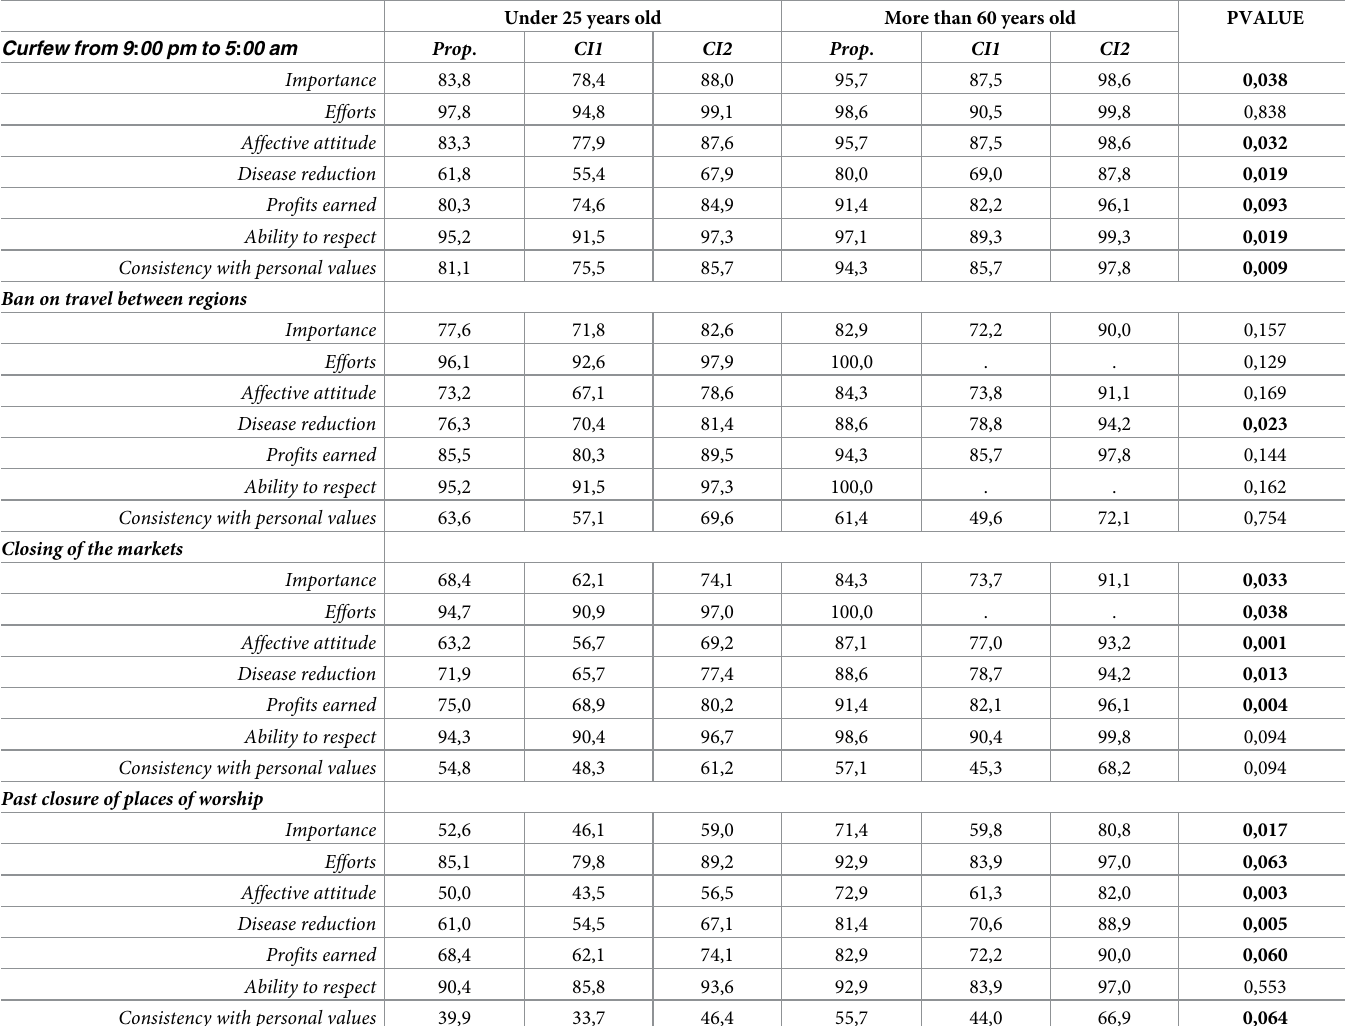
Table 3. Acceptability of the four measures according to the two age